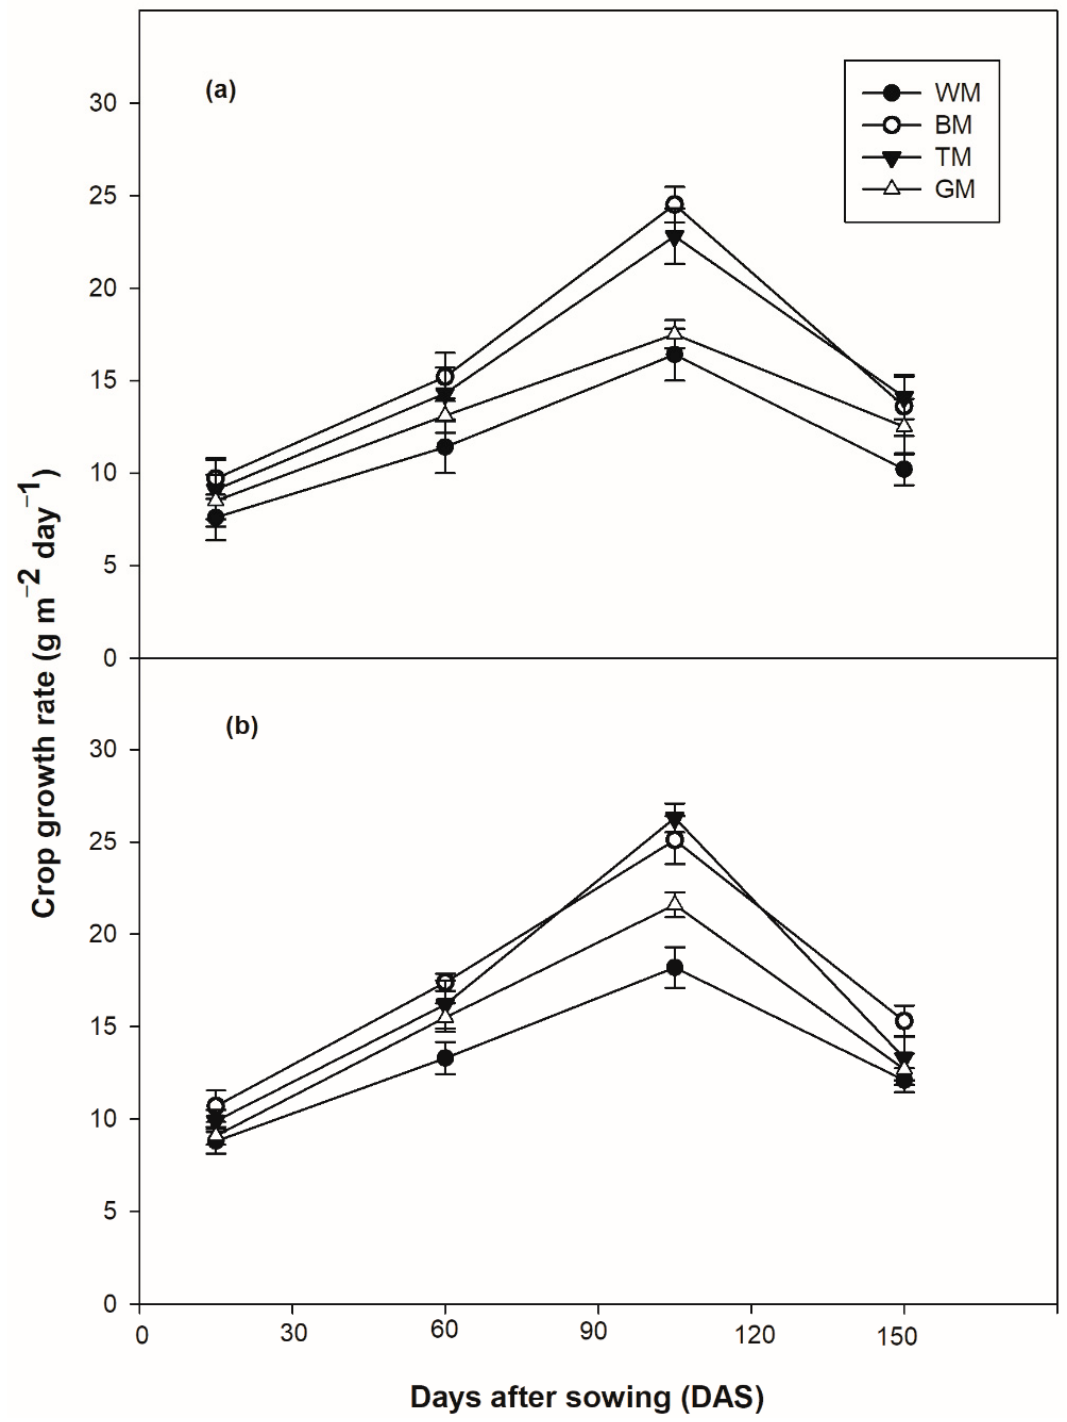
Figure 4. Crop growth rate ( CGR ) of maize under ridge-furrow without mulching (WM), with black plastic mulch (BM), transparent plastic mulch (TM) and grass mulch (GM) in 2017 ( a ) and 2018 ( b ). Soil water storage (SWS) indicated a slight difference among the four treatments (Figure 5). Compared to the WM treatment, all mulching treatments augmented the SWS significantly during both growing seasons. The quantity of water storage from 1st (30 DAS) to 2nd (60 DAS) sampling was recorded to be improved with BM, TM and GM treatments in 2017 and 2018, as well as being the most vital water restoring time for crop growth. While, from the 2nd (60 DAS) to the 4th (120 DAS) sampling, differences between the